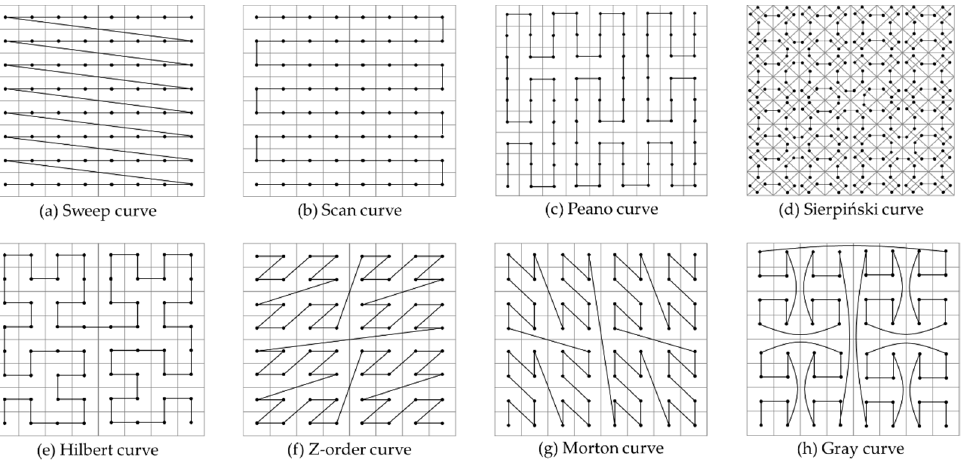
Figure 2. Typical space-filling curves.